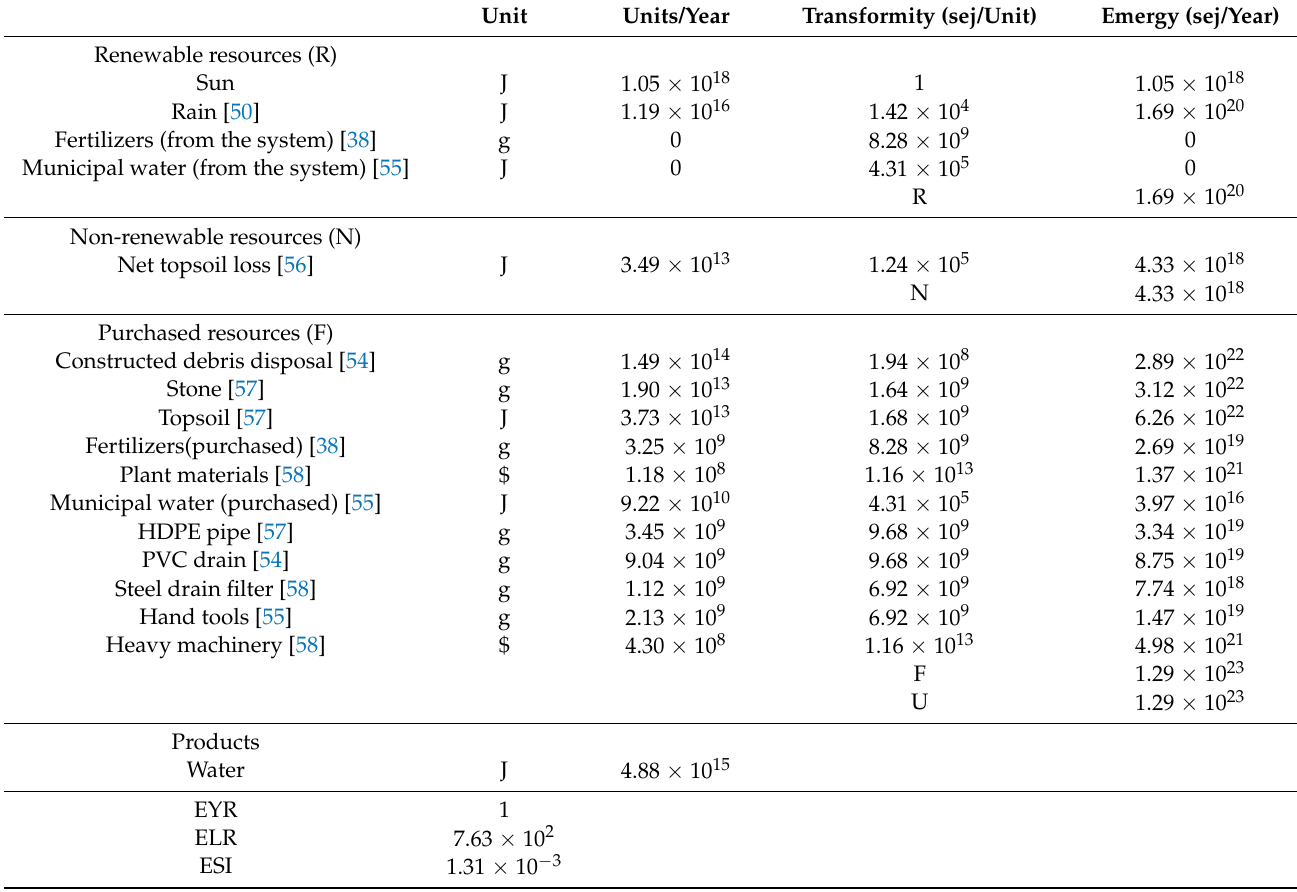
Table 5. Emergy calculation of rainwater garden subsystem (before). Unit